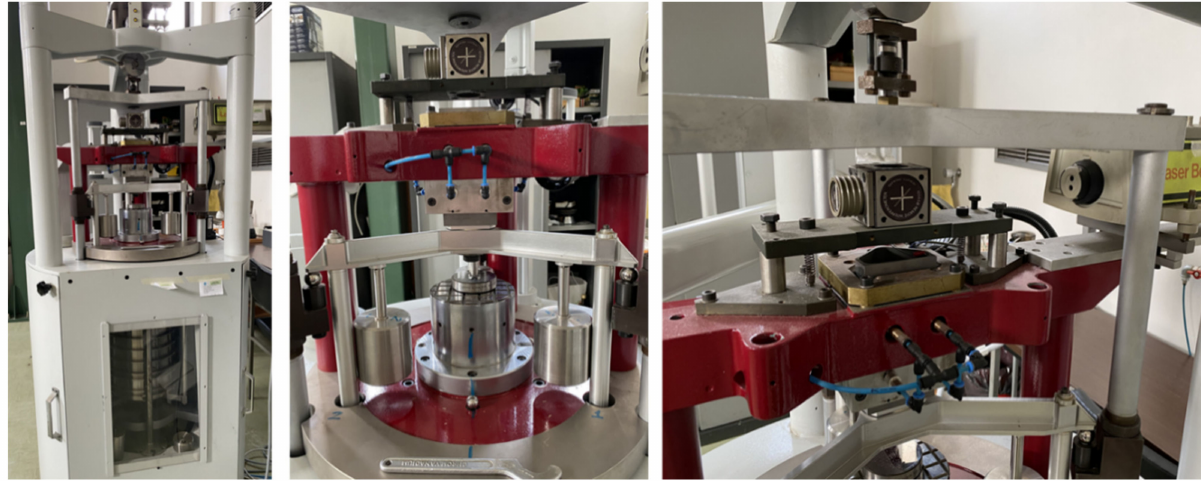
Figure 1. Experimental measuring systems used in this investigation: primary hardness standard deadweight machine with the details of the anvil and the interferometric